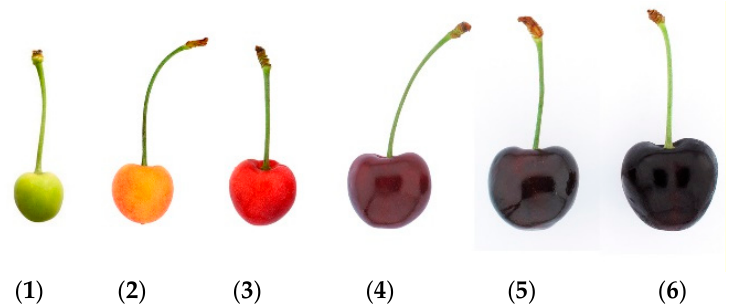
Figure 1. Phenological stages of cherry fruit . From left to right: ( 1 ) green or pre- véraison , ( 2 ) yellow or véraison , ( 3 ) bright red (UC color chart 3.0; hue = 10–12°), ( 4 ) mahogany (UC color chart 3.5; hue= 7–9°) or commercial harvest, ( 5 ) dark mahogany (UC color chart 4.0; hue = 3–6°) and ( 6 ) black or overripe (UC color chart 5.0; hue = 2°).